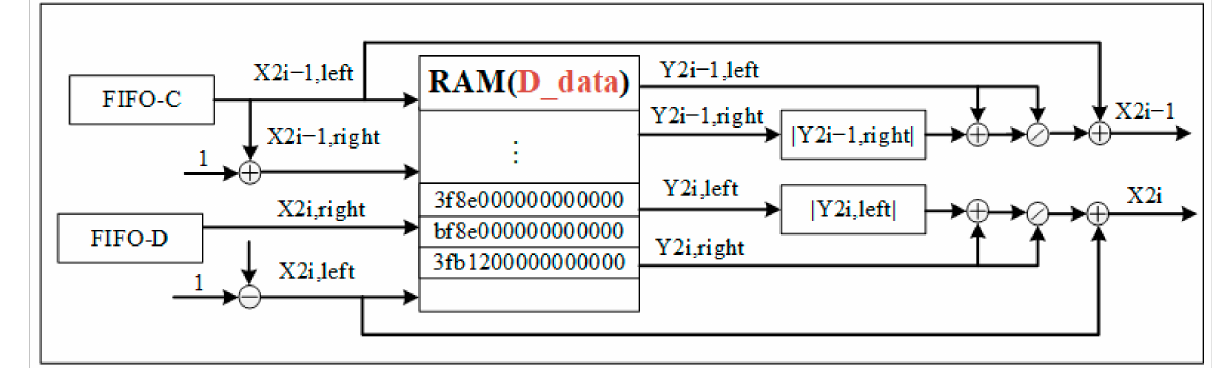
Figure 11. Inflection point coordinate calculation module.